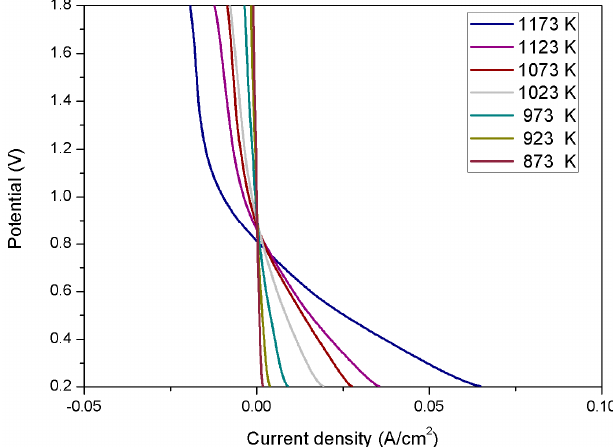
Figure 6 . The I / V curves of the SCGZ electrolyte - supported SOEC conducted from 873 K to 1173 K Figure 6. The I / V curves of the SCGZ electrolyte-supported SOEC conducted from 873 K to 1173 K under a constant steam to hydrogen ratio ( 70 : 30 ). under a constant steam to hydrogen ratio (70:30). Processes 2019 , 7 , x FOR PEER REVIEW